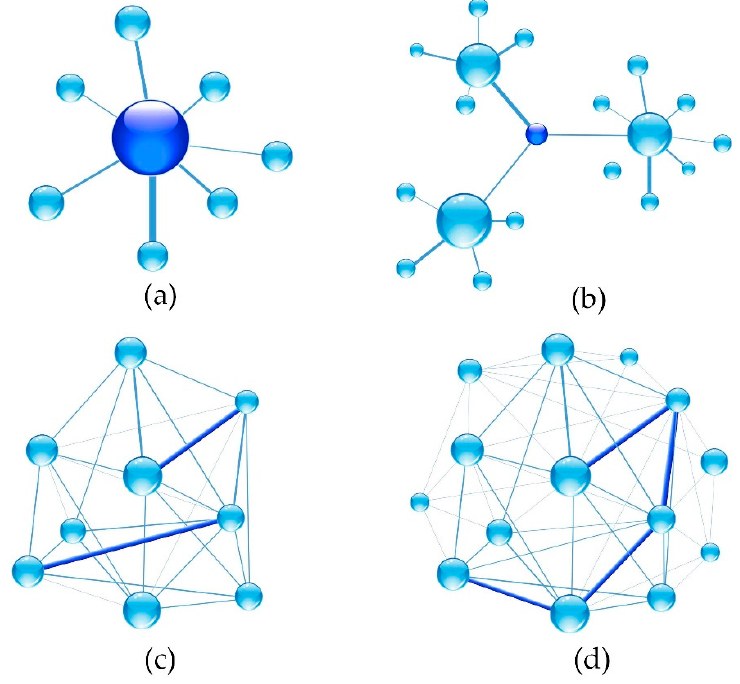
Figure 10. Schematic of key nodes and key edges in the network. ( a – d ) represent the key node, the node with a large eigenvector centrality value, the key edge, and the key path, respectively.